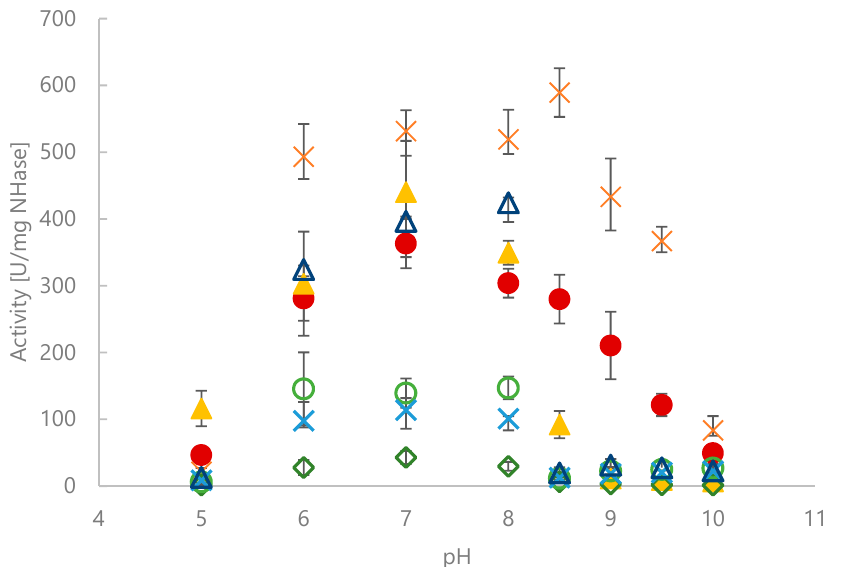
Figure 3. Activities of NHase CFEs for MAN hydrolysis at different pH values and 25 °C. Citrate-phosphate buffer pH 5–6, sodium phosphate buffer pH 7–8, Tris-HCl buffer pH 8.5, carbonate buffer pH 9–10. Ct NHase: filled dark red circles. Ko NHase: filled orange squares. Na NHase: filled yellow triangles. Gh NHase: green rhombs. Pk NHase: light green circles. Pm NHase: blue crosses. Re NHase: dark blue triangles.